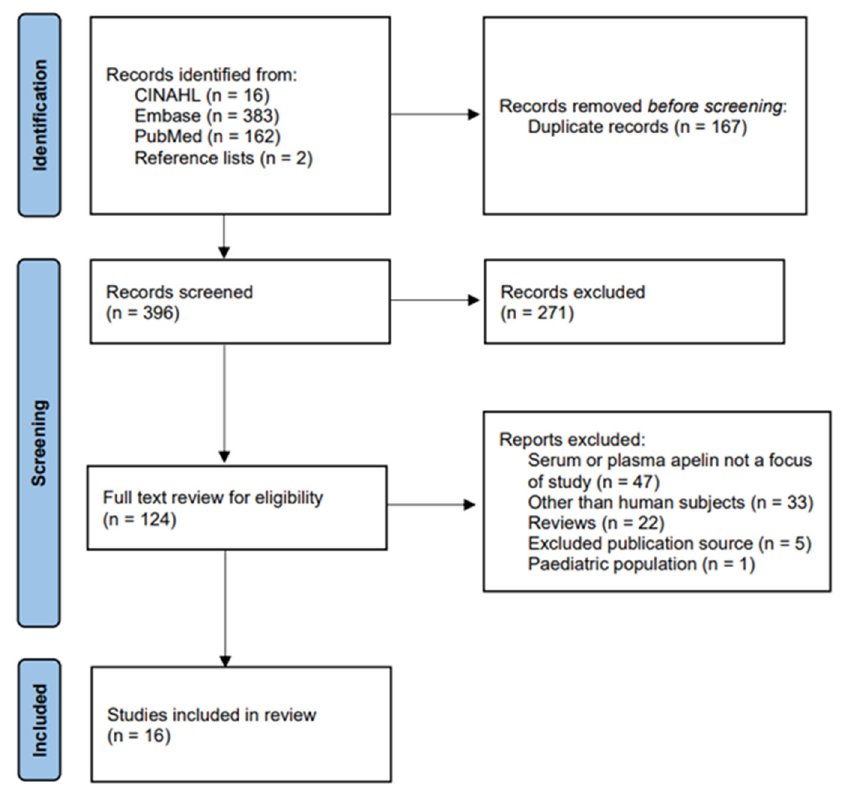
Figure 1. PRISMA diagram [16].